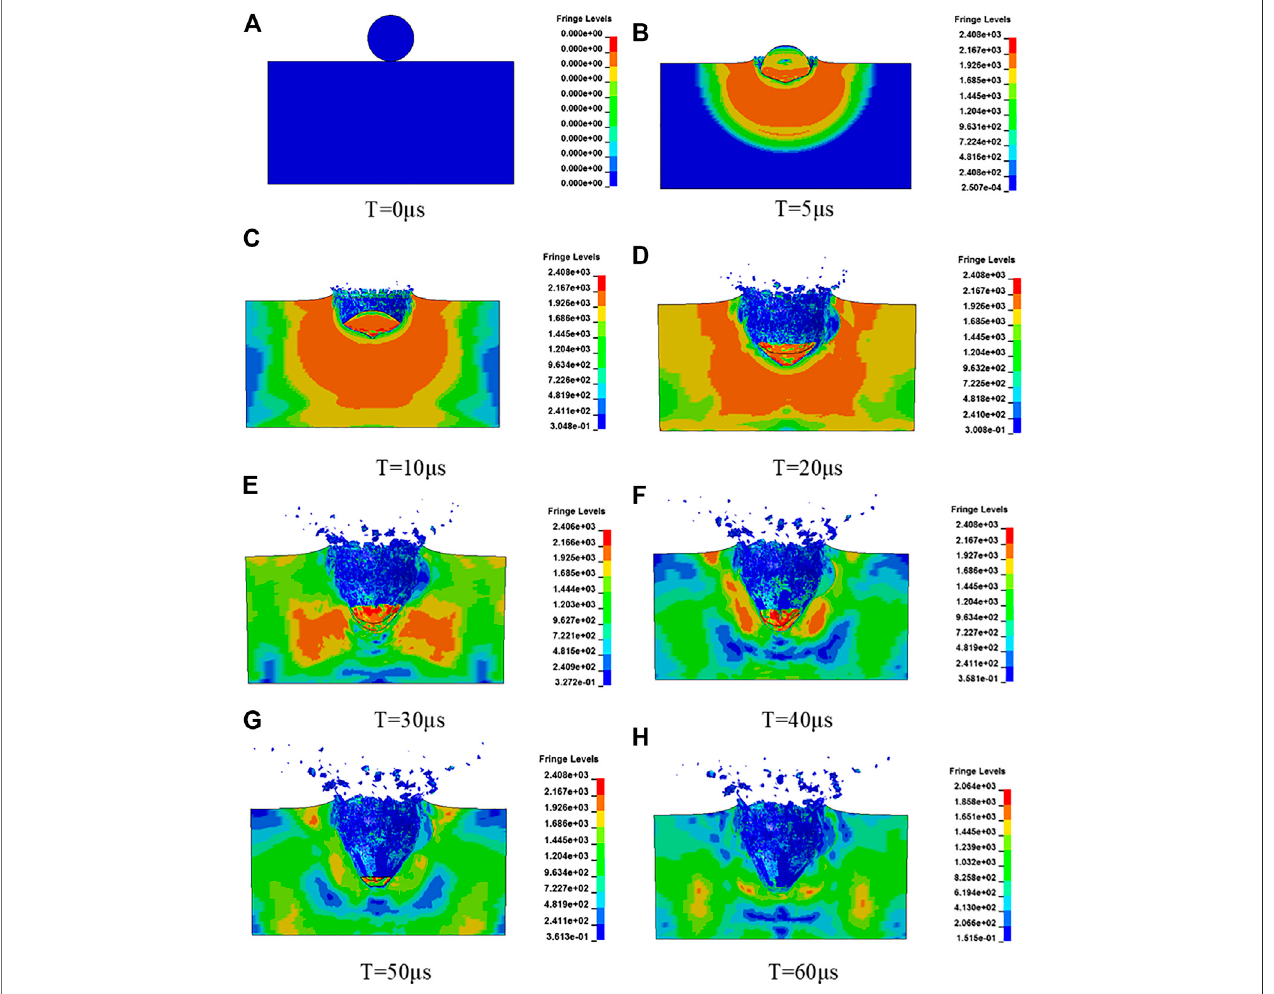
FIGURE9| SchematicdiagramsofpenetrationoftungstensphereintoG50steelattheimpactvelocityof1,800 m/satdifferenttimes. (A) T (cid:1) 0 µs, (B) T (cid:1) 5 µs, (C) T (cid:1) 10 µs, (D) T (cid:1) 20 µs, (E) T (cid:1) 30 µs, (F) T (cid:1) 40 µs, (G) T (cid:1) 50 µs, and (H) T (cid:1) 60 µs.